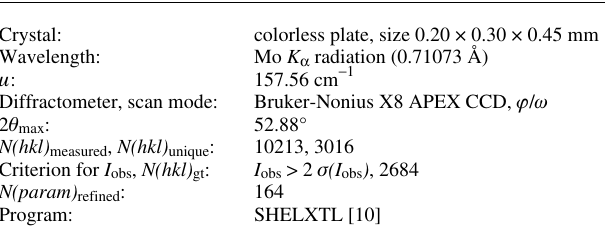
Table 1. Data collection and handling.